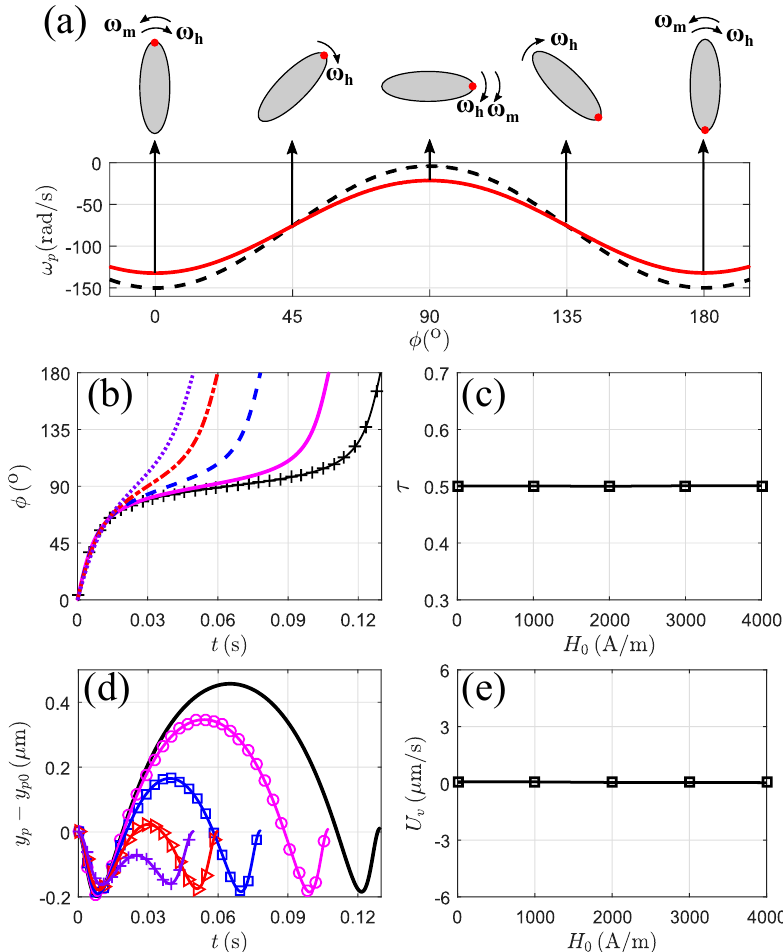
Figure 10. Effect of the magnetic field when it is applied at α = 135 ◦ . The particle ( AR = 4) is initially located at y p 0 = 12 µ m. ( a ) ω p versus φ for H 0 = 0 (dash) and 3000 A/m (solid); ( b ) φ versus t over a period for H 0 = 0 (plus), 1000 A/m (solid), 2000 A/m (dash), 3000 A/m (dash-dot) and 4000 A/m (dot); ( c ) the dimensionless parameter τ as a function of H 0 ; ( d ) the migration of particle y p − y p 0 with time t over a period for H 0 = 0 (solid), 1000 A/m (circle), 2000 A/m (rectangle), 3000 A/m (triangle) and 4000 A/m (plus); and ( e ) dependence of lateral migration velocity U v on magnetic field strength H 0